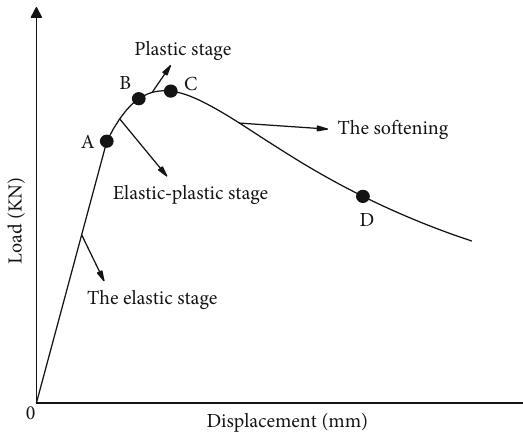
Figure 3: Position of strain gauge.